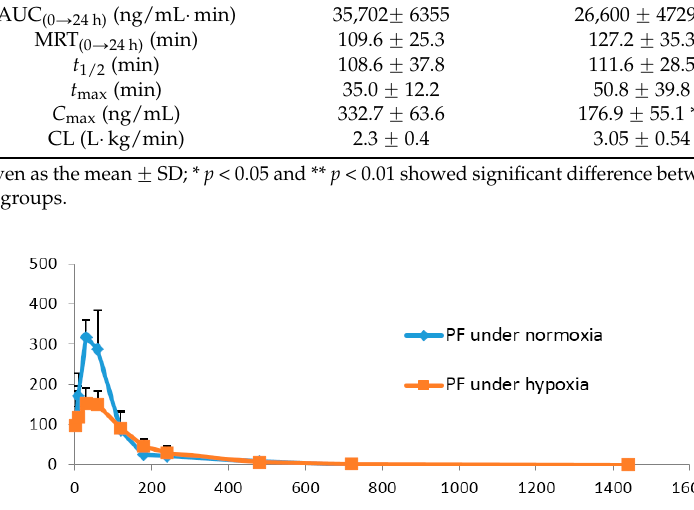
Figure 5. The mean plasma concentration–time profiles of paeoniflorin (PF) in rat under normoxia and hypoxia condition. PF was administered orally to rats. The values are the mean ± SD, n = 6. Table 5. The main pharmacokinetic parameters of AF under normoxia/hypoxia in rat plasma after a single intragastrical administration ( n = 6).